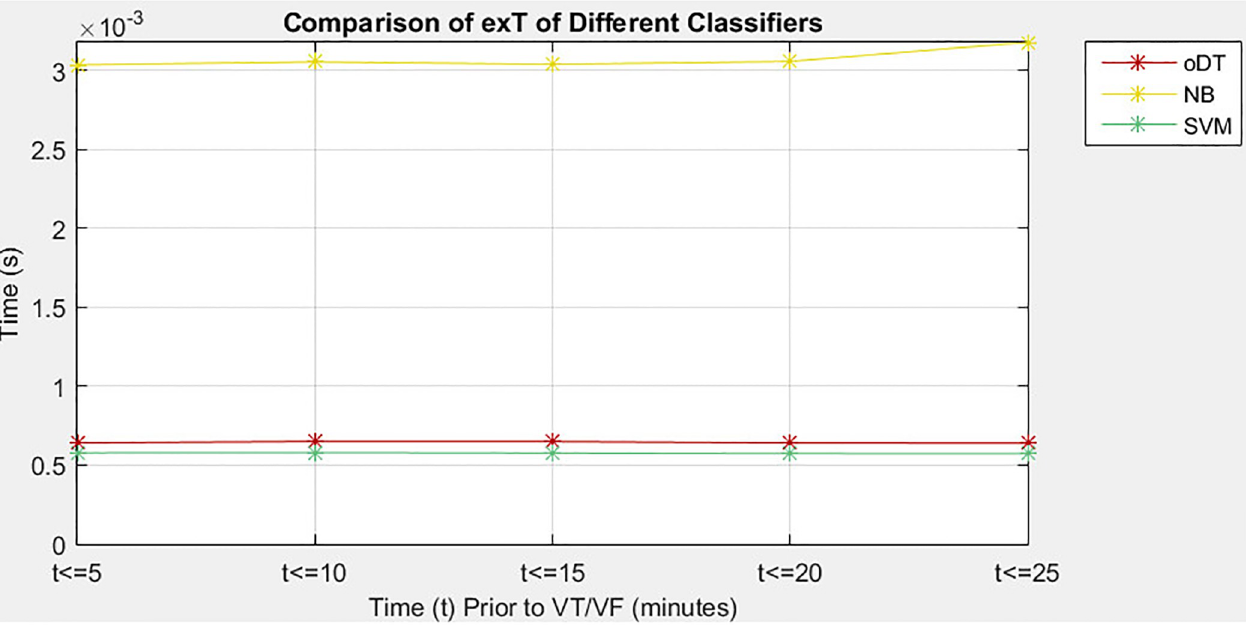
Fig 8. Comparison of exT among oDT, NB and SVM.